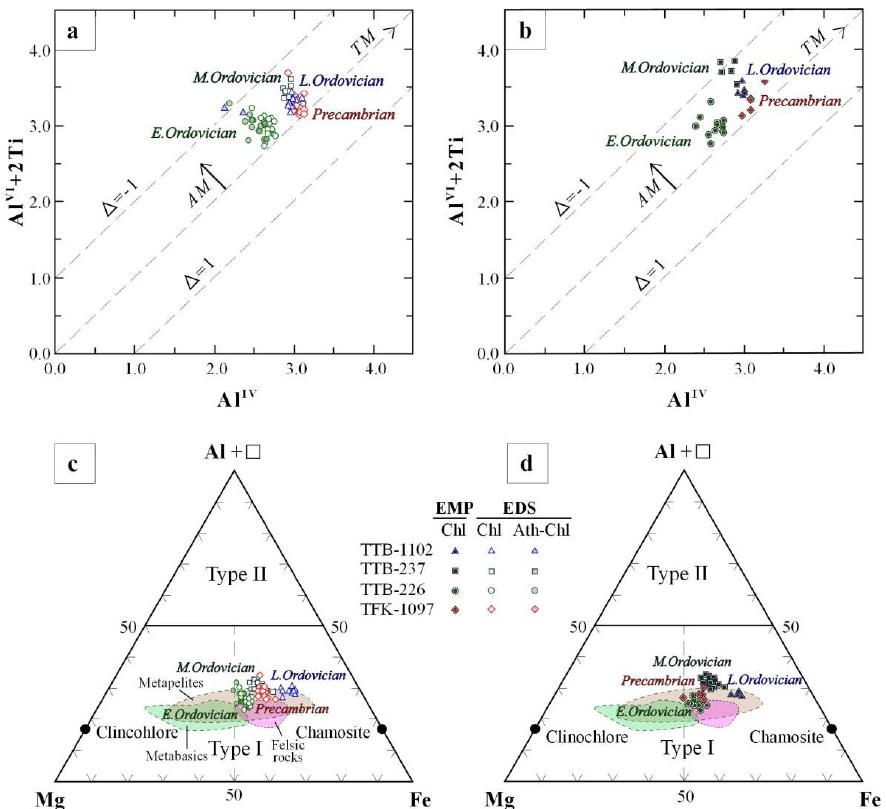
Figure 11. Distribution of chlorite compositions on classification diagrams. ( a , b ) Al VI + Ti vs. Al IV [57]; ( c , d ) octahedral Al + (cid:0) –Mg–Fe [58]. ( a , c ) and ( b , d ) represent the analytical results by EDS and EMP, respectively. Δ = Al IV − Al VI + 2Ti, (cid:0) = Octahedral vacancy, Type I = X Mg + X Fe ≥ X Al + X (cid:0) , Type II = X Mg + X Fe < X Al + X (cid:0) . The TM and AM arrows point towards increasing Tschermak and dioctahe- dral substitutions, respectively.